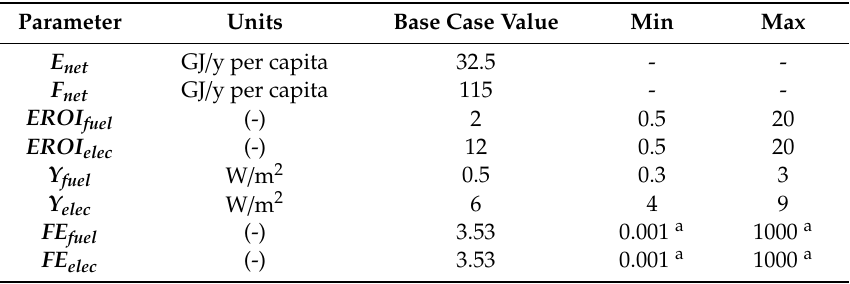
Table 2. Base case values and range for sensitivity analysis.